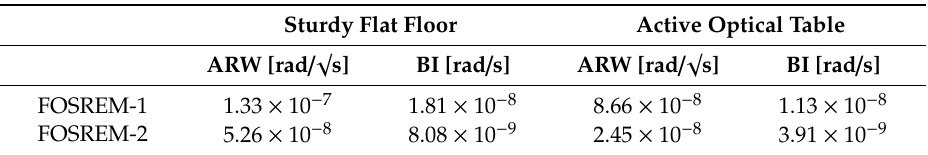
Figure 6. The Allan variance analysis for FOSREM-1 and -2 determined from the data gathered in various positions of the FOSREMs: ( a ) sensors were placed on the sturdy flat floor in the basement of the laboratory; ( b ) sensors were placed on the active optical table. Table 1. The parameters of Angle Random Walk (ARW) and Bias Instability (BI) for FOSREM-1, -2 determined from the data gathered in various positions of